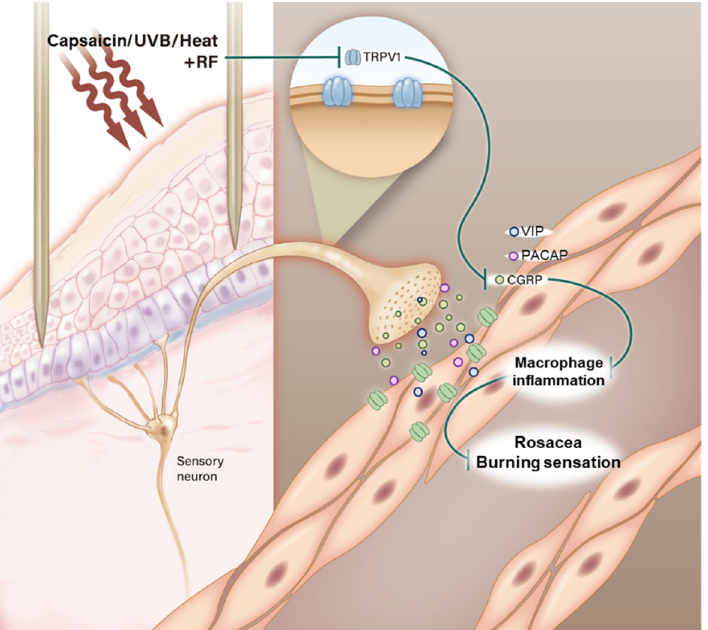
Figure 6. Illustration shows how RF irradiation in Capsaicin, UVB or heat-treated sensory neurons decreased neuropeptides including CGRP, PACAP and VIP and these molecules modulated CD163-positive macrophage and inflammation. Finally, facial temperature of Rosacea patients effectively decreased.